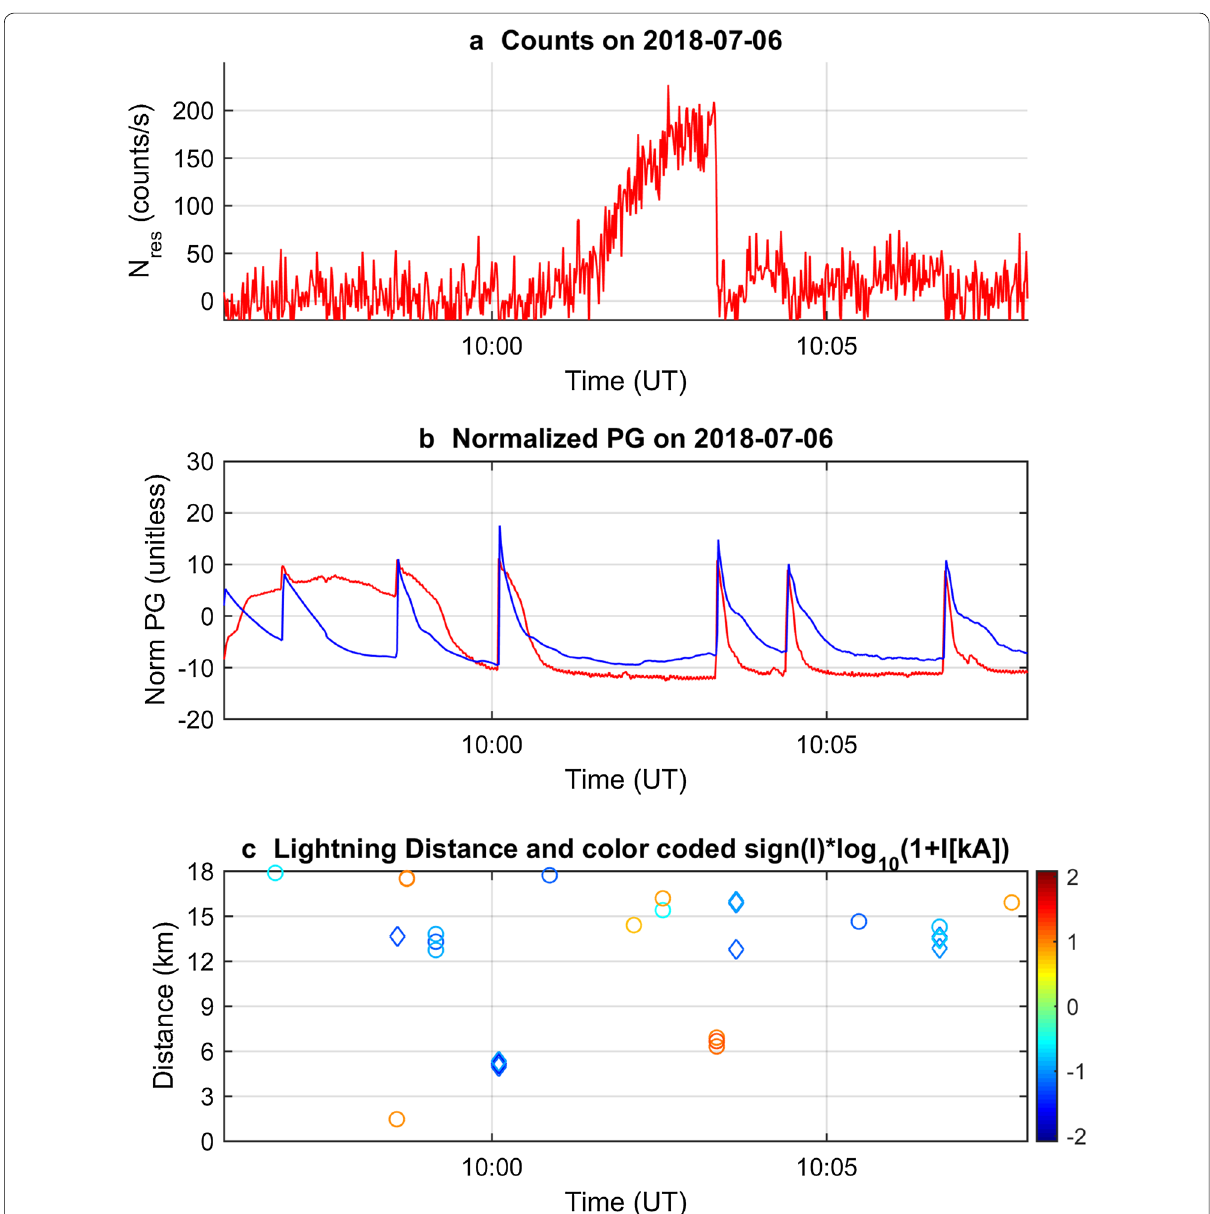
Fig. 4 Event recorded on 6 July 2018 around 10:02 UT. a Residual counts at Lomnicky peak by red. b Normalized PG at Lomnicky peak (red) and Skalnate Pleso (blue). c Lightning distances from Lomnicky peak as recorded by EUCLID lightning detection network; CG discharges are by diamonds, IC by circles, peak current I is color-coded; the color approximately corresponds to the common logarithm of the peak current in kA, sign of the current is